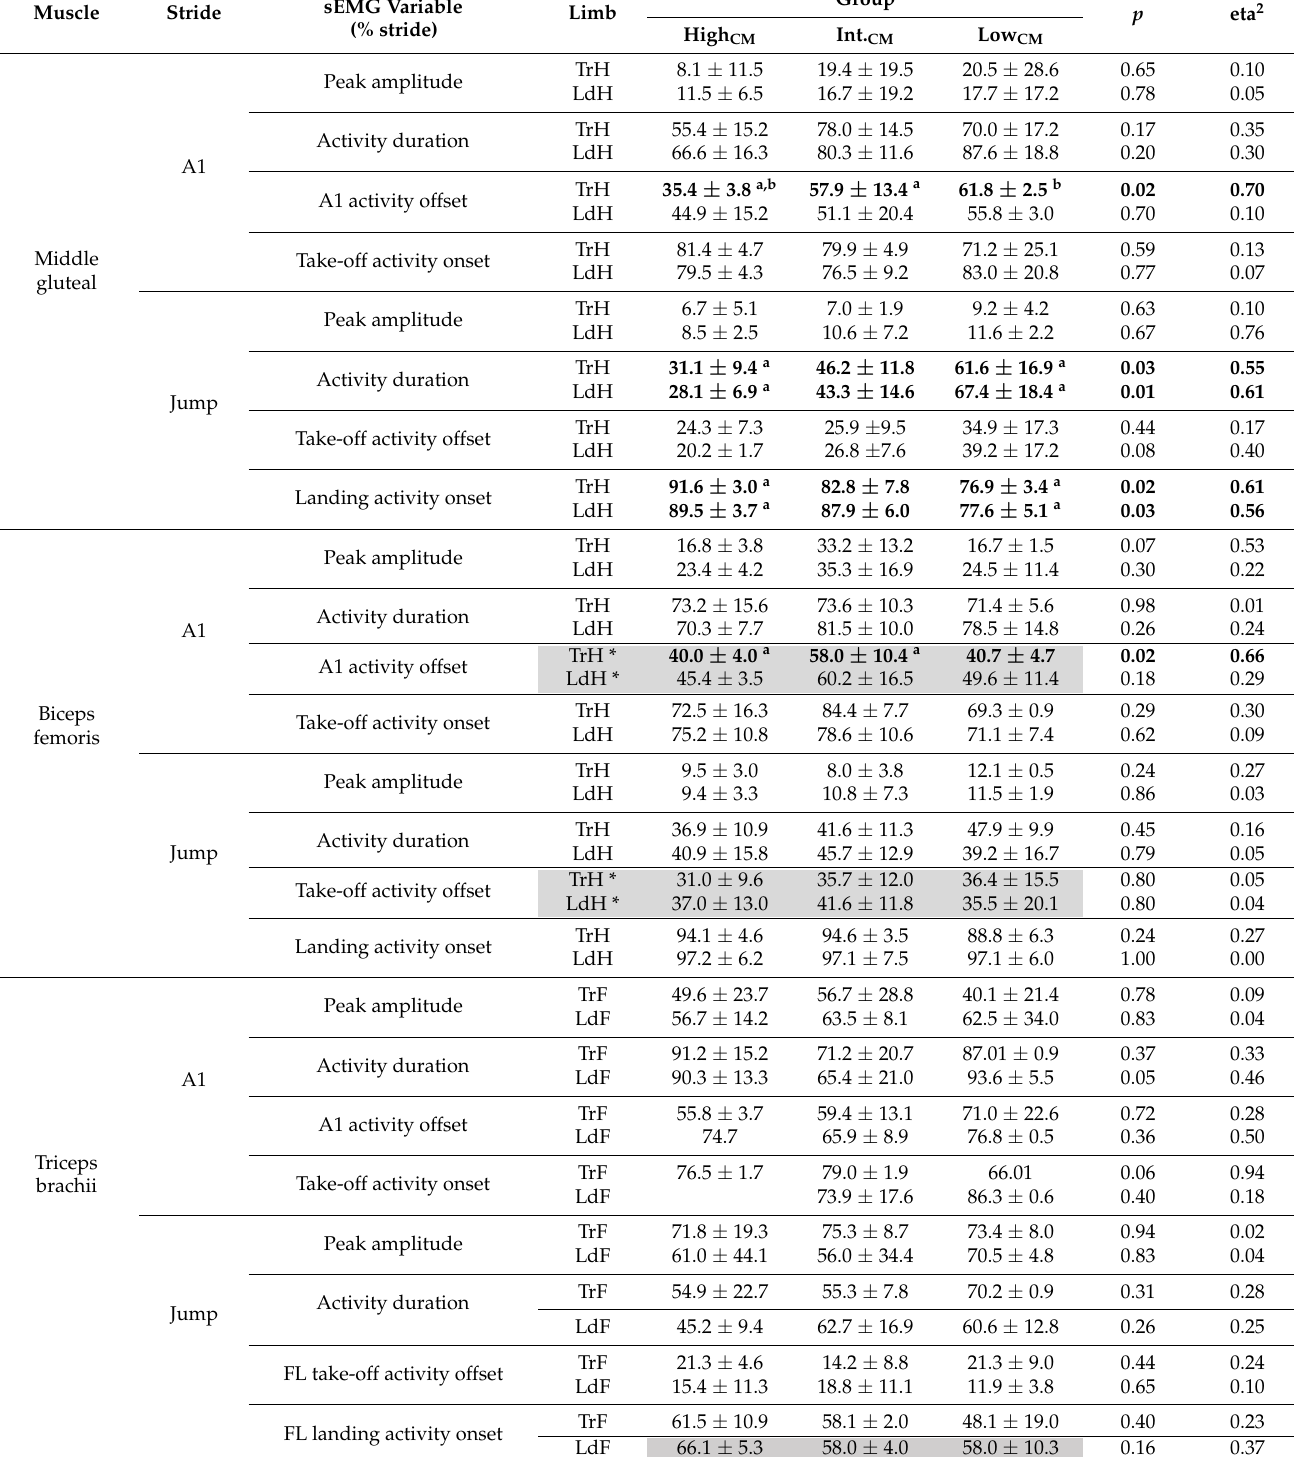
Table 2. Descriptive statistics (mean ± standard deviation) for sEMG variables within each subgroup and muscle. Between- group differences are presented for each variable as p-values and effect sizes (eta 2 ). Within each row, significant main effects ( p < 0.05) for between-group differences are denoted by bold text and significant differences ( p < 0.05) between groups are represented by corresponding superscripts ( a–b ). Significant differences ( p < 0.05) between groups are denoted by bold text and between limbs as grey shaded